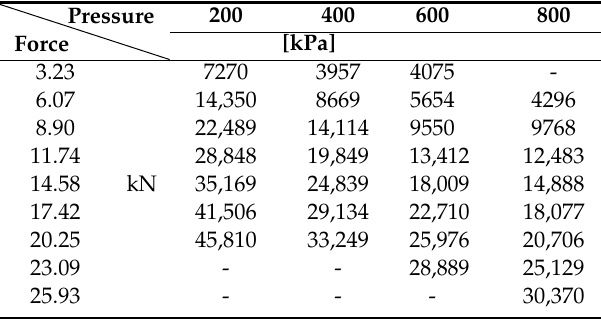
Table 4. Surface area values resulting from testing the Su-22 aircraft tire (results in mm 2 ).